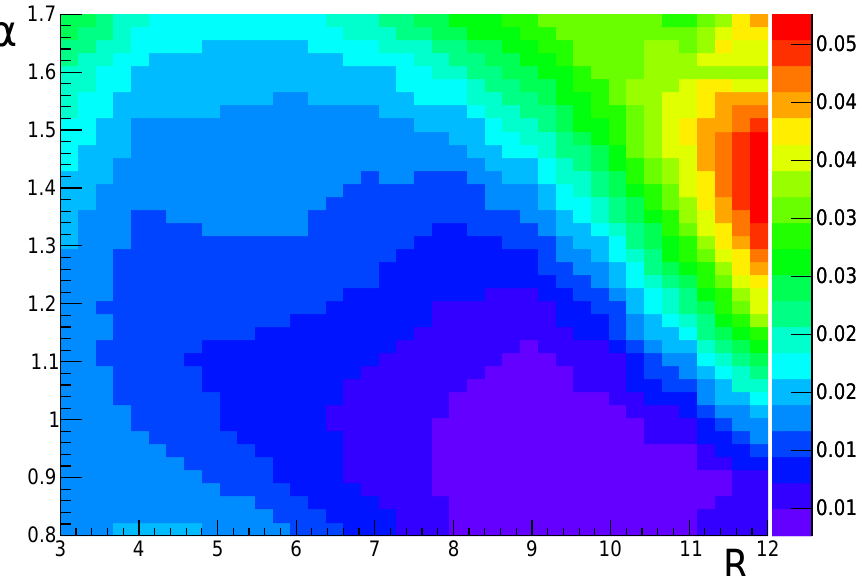
Figure 5. The relative deviation of the parametrization measured in % form the table for the domain of the parameterization in α (0.8–1.7) and in R (3–12 fm), averaged over a q region of 0.01 to 0.1 GeV/ c